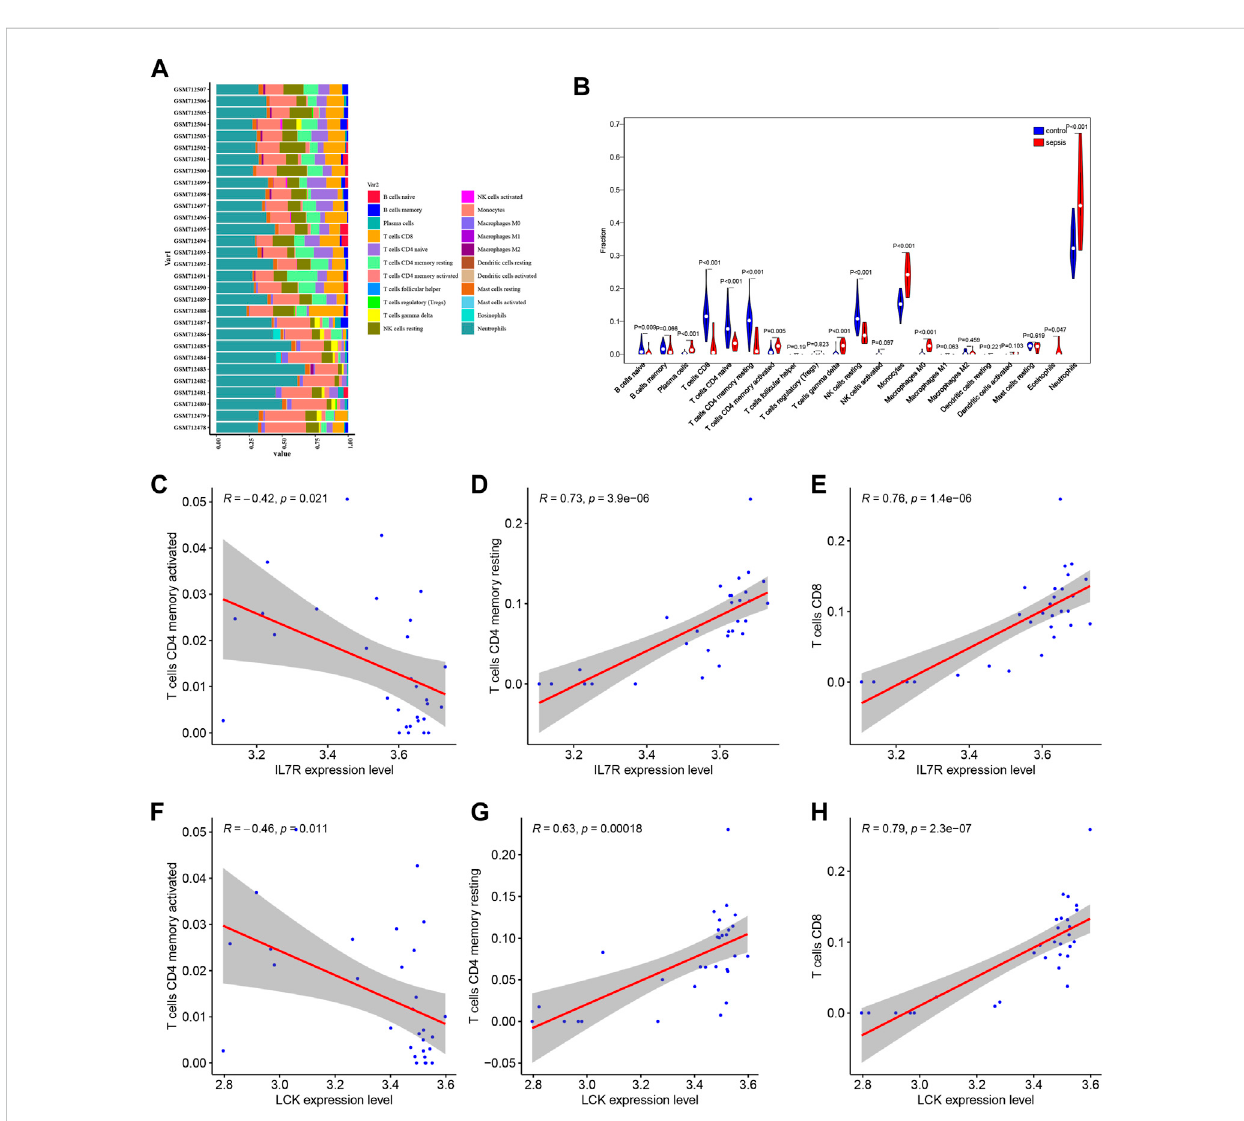
FIGURE 7 Analysis and visualization ofimmunecell in fi ltration. (A) Proportion of immune cell in fi ltration in GSE28750 data set. (B) Boxdiagram ofimmunecell in fi ltrationinGSE28750 dataset.Red wasthesepsisgroup andbluewasthecontrol group. (C – F) Correlation betweenhubgenesandimmunecells. IL7R was negatively correlated with T cells CD4 memory activated (C) . IL7R was positively correlated with T cells CD4 memory resting (D) . IL7R was positively correlated with T cells CD8 (E) . LCK was negatively correlated with T cells CD4 memory activated (F) . LCK was positively correlated with T cells CD4 memory resting (G) . LCK was positively correlated with T cells CD8 (H)